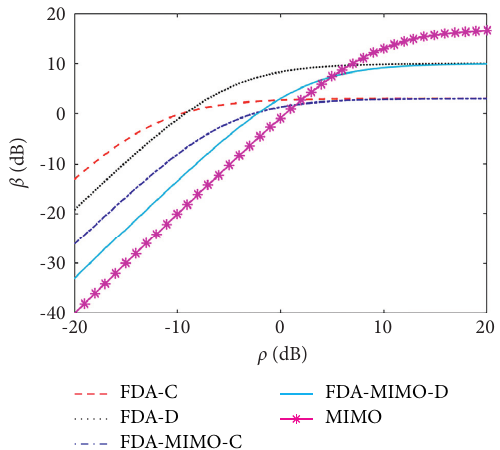
Figure 3: Detector’s SNR of various systems. M � N � 5.